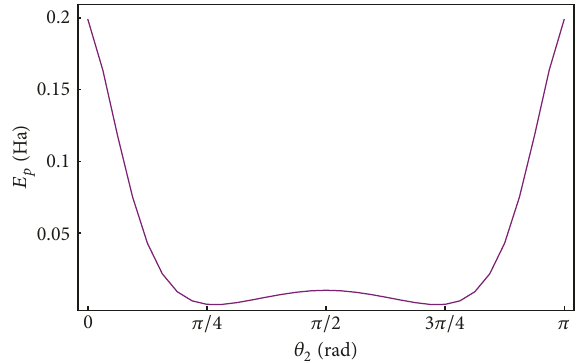
Figure 10: A slice of the Legendre polynomial expansion of orthodinitrobenzene, considering symmetric rotations of the nitro groups, with both nitro groups rotating